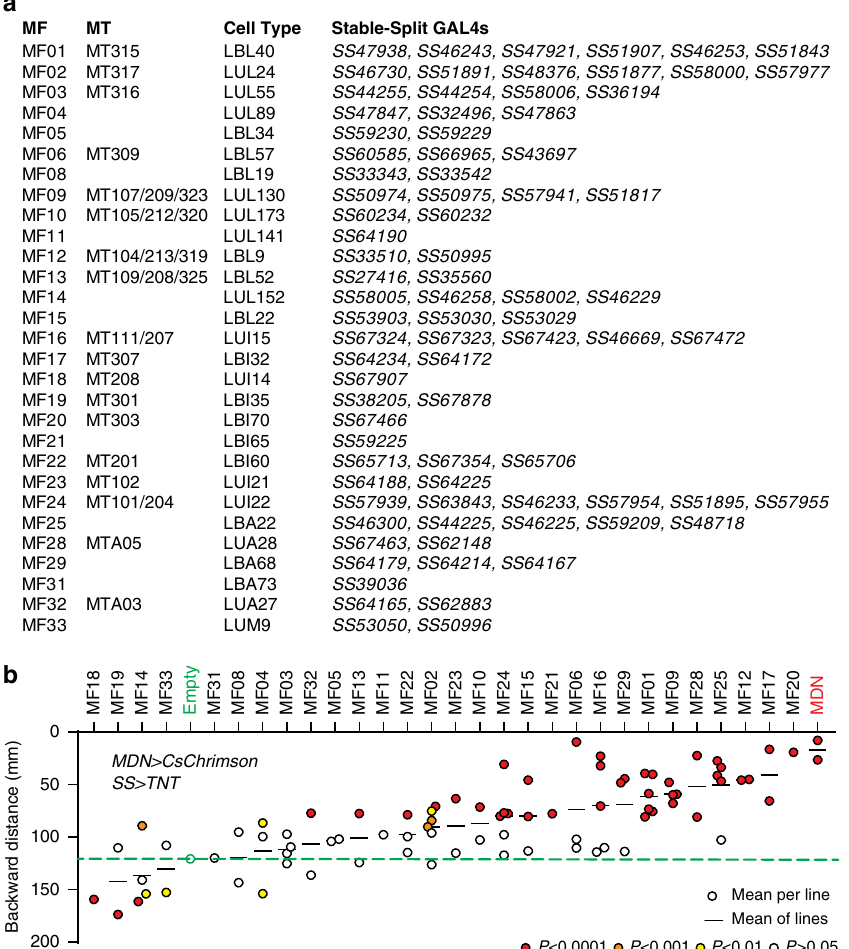
Fig. 4 Several MF cell types contribute to MDN-induced backward walking. a Correspondence between 29 MF cell types, their matching MT cell types, cell types identi fi ed in a systematic analysis of leg neuropil neurons, and the split-GAL4 lines that label them and were used to generate the data shown in b . b Total backward walking distance during 9 episodes of 5-s photoactivation of MDN, in fl ies in which a single MF cell type was silenced. Each data point represents the mean of all fl ies tested with a single split-GAL4 line, shaded to indicate P values from one-way ANOVA tests with post-hoc Dunnett ’ s correction for multiple comparisons. For cell types for which multiple split-GAL4 lines were tested, the mean across all lines is shown. Dashed green line marks the backward walking distance of negative control fl ies, for comparison. See also Supplementary Fig. 3b. and Supplementary Movie 4. Source data are provided as a Source Data fi